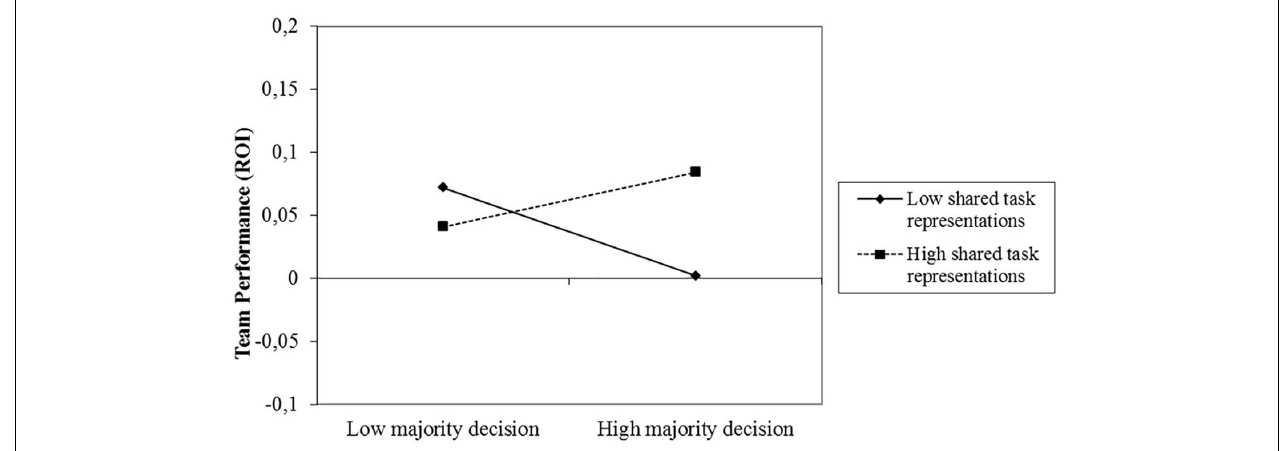
FIGURE 3 | Team performance (ROI) as predicted by majority decision-making and shared task representations.